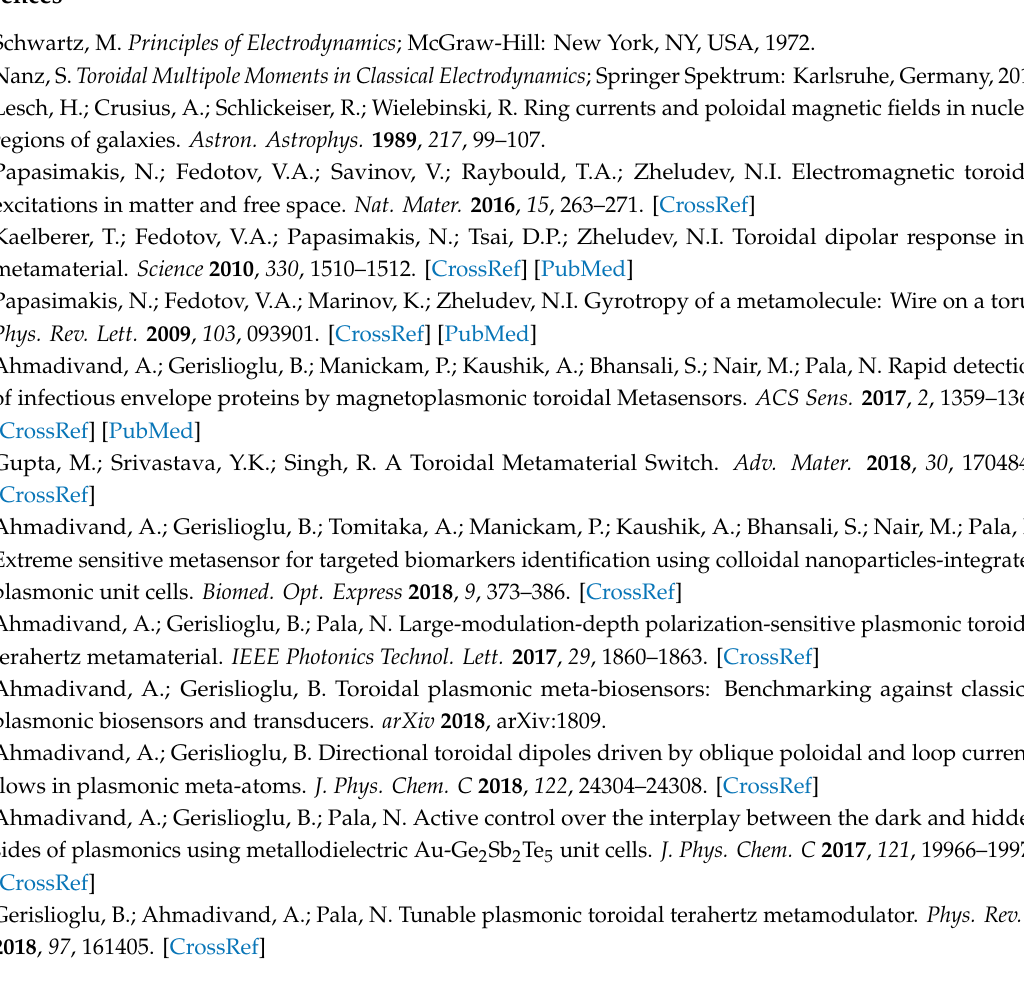
Figure S1: Theoretically computed transmission spectrum, Figure S2: Magnetic field